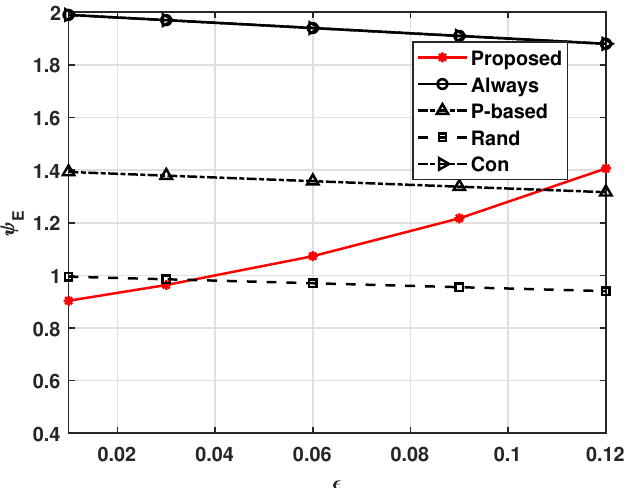
Figure 3. Average energy consumption ψ E versus (cid:101) .